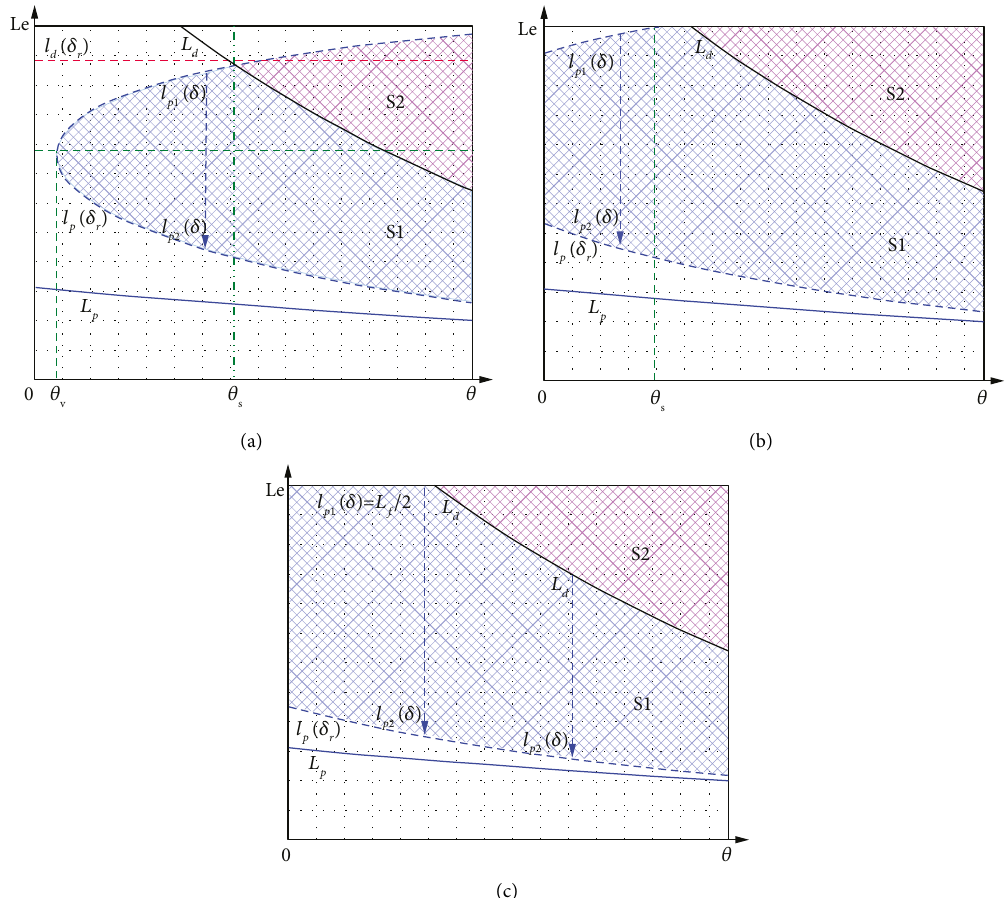
Figure 12: Developing of the slipping rupture zone S1 . (a) 0 < θ